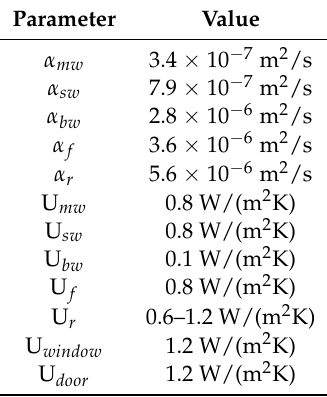
Table 2. Thermal parameters associated with the heating